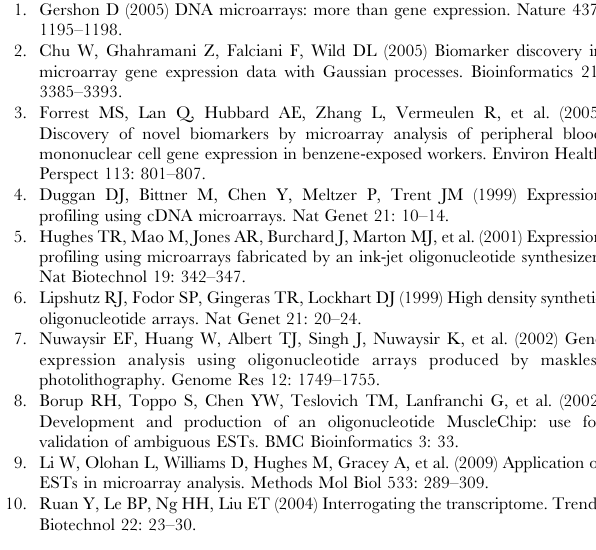
Table S2 SeqMan assembled contigs. Name and sequence of 63,602 contigs assembled using SeqMan Pro (build 7.2 with default settings).